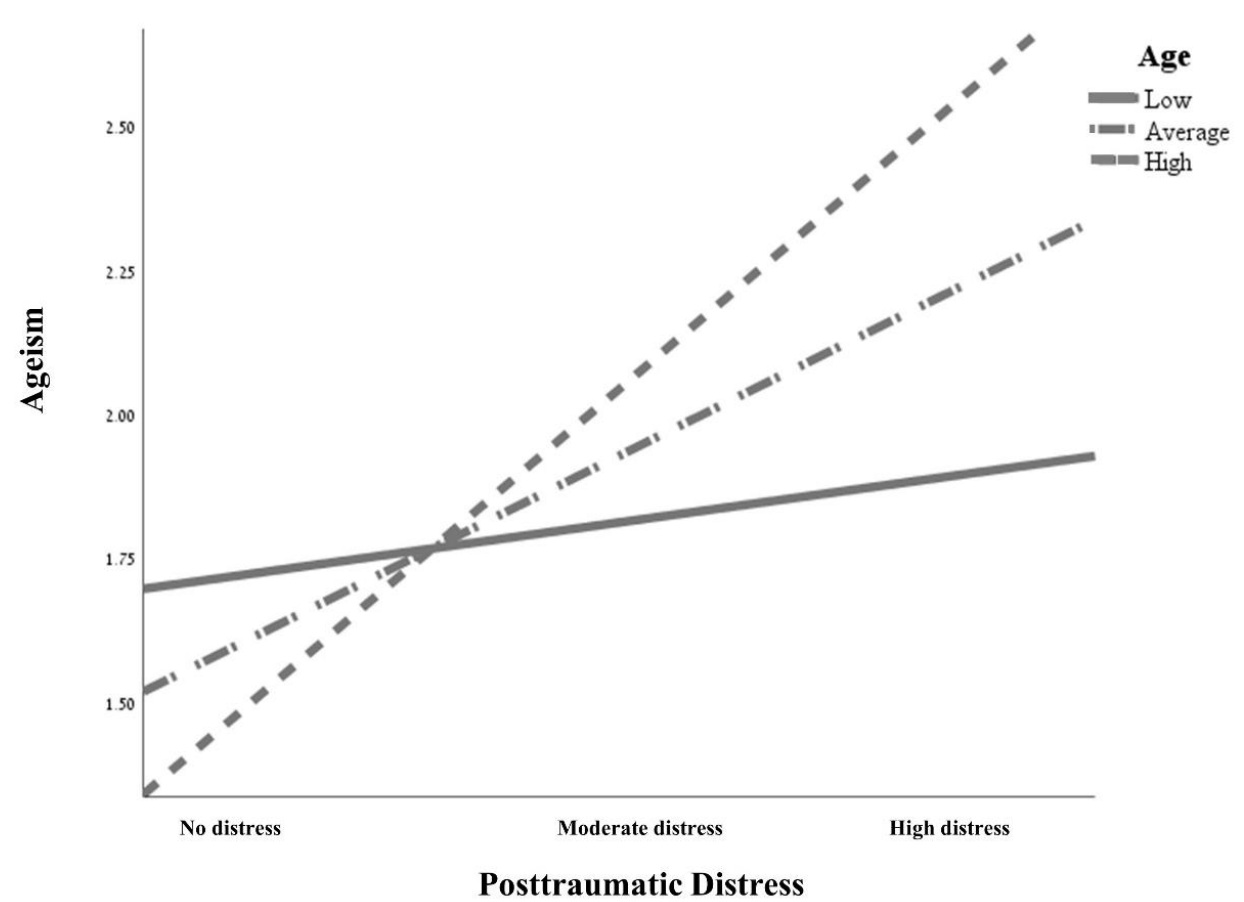
Figure 1. Interaction between Age and Posttraumatic Distress Predicting Ageism.